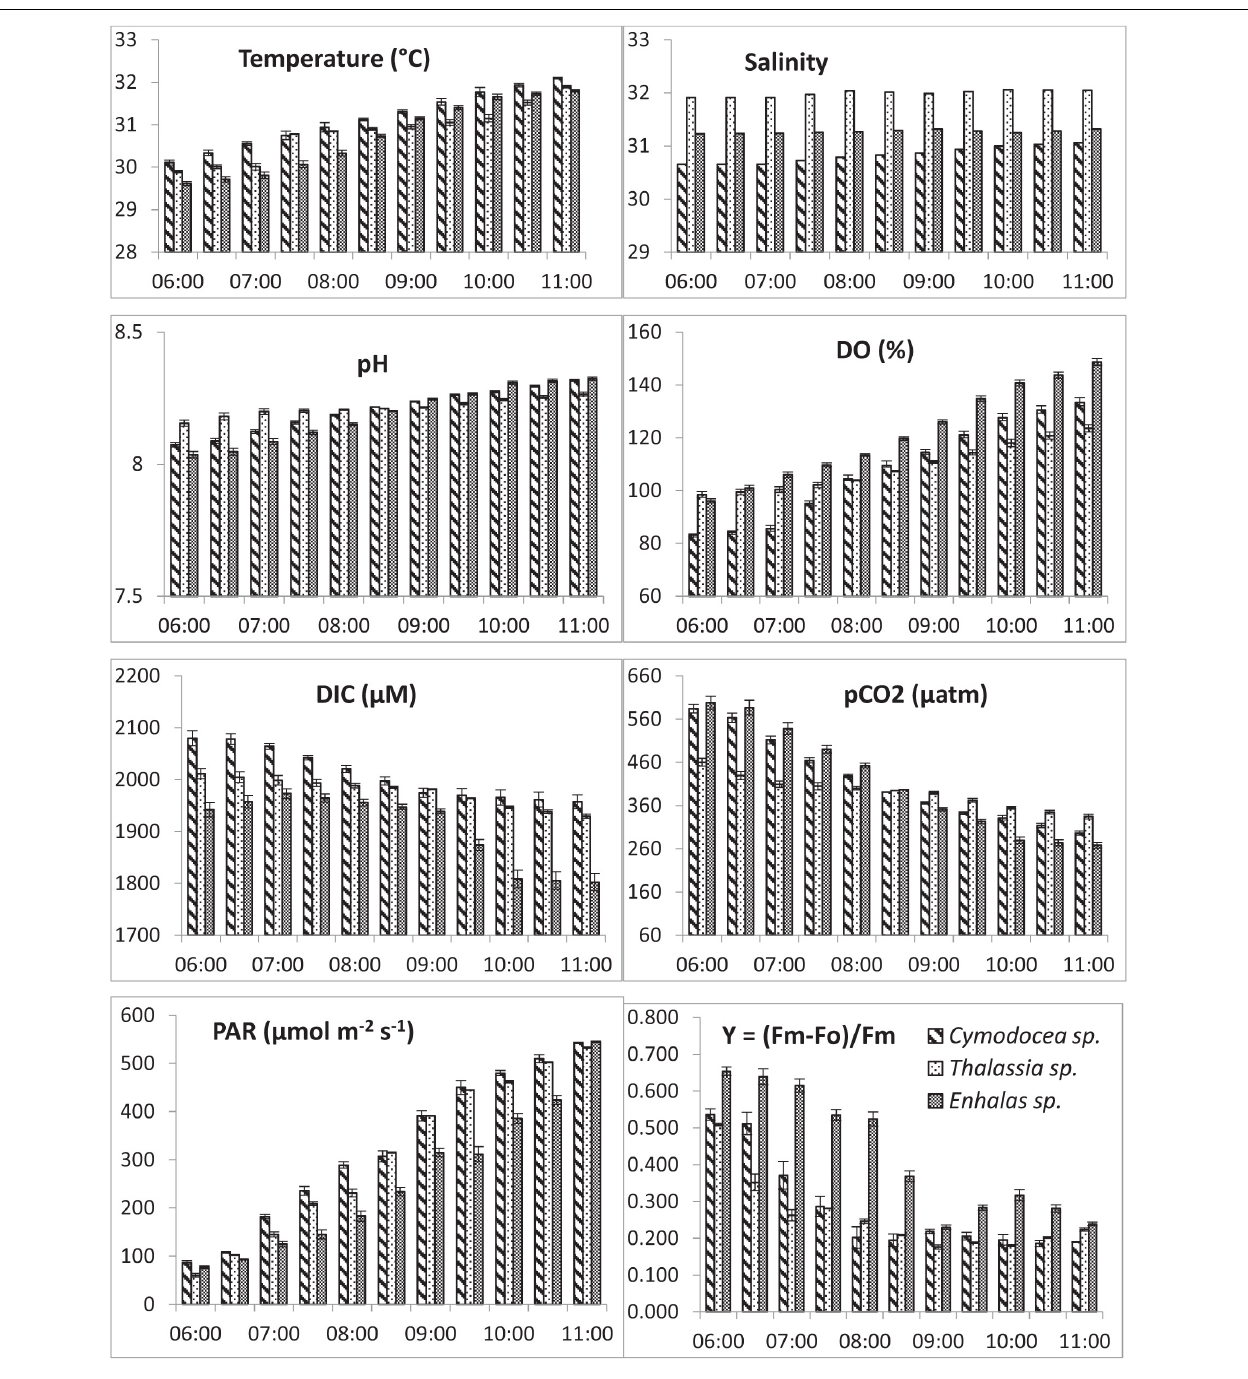
FIGURE 2 | Hourly variations in water quality; Temperature, salinity, pH, dissolved Oxygen saturation (DO%), Dissolved Inorganic Carbon (DIC), partial pressure of carbon dioxide (pCO2), available Photosynthetically Active Radiation (PAR) and effective quantum yield (Y) for the three studied species in Palk